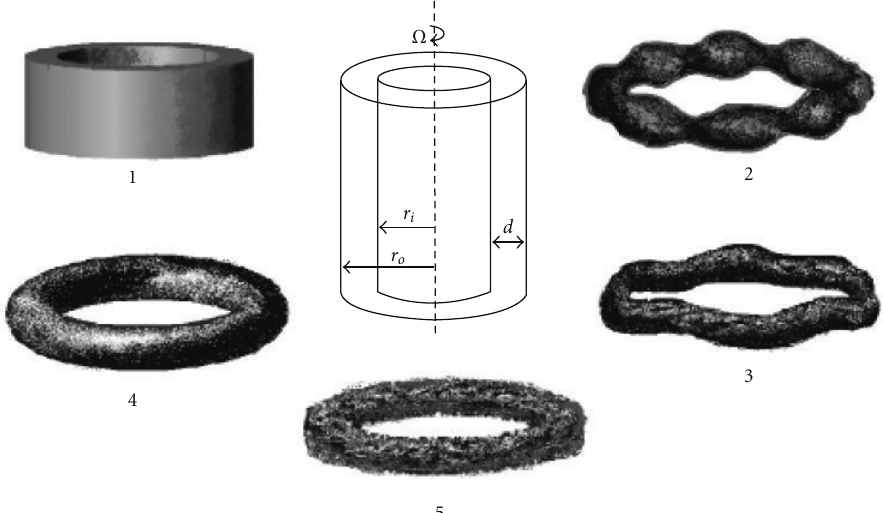
Figure 3: System of concentric cylinders and various vortex patterns in the absence of axial flow: (1) couette flow, (2) wavy vortex flow, (3) chaotic vortex flow, (4) Taylor vortex flow and, (5) turbulent Taylor vortex